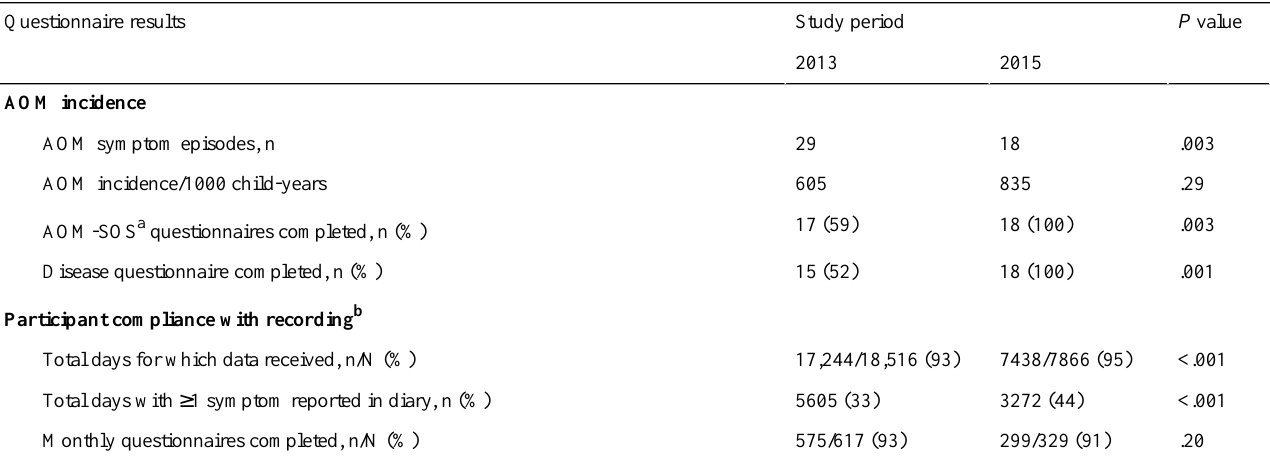
Table 2. Acute otitis media (AOM) incidence and participant compliance with study procedures.